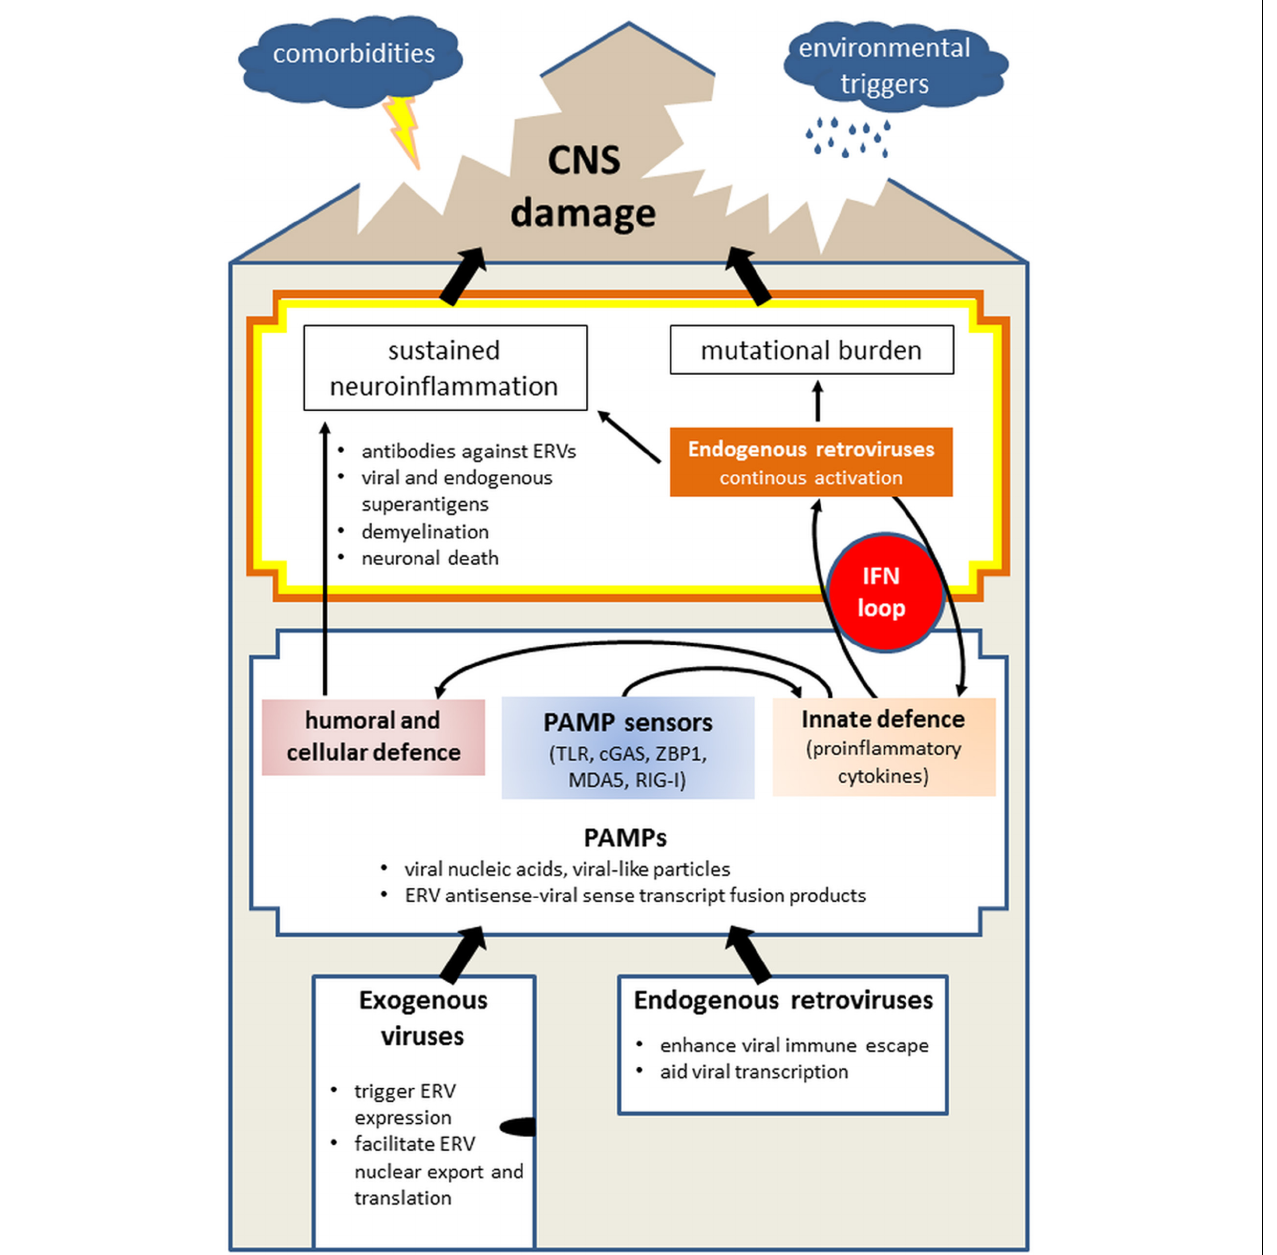
FIGURE 2 | Model of the role of exogenous virus and endogenous retrovirus (ERV) in initiating neuropathologies, illustrating the entry of viruses into the body (“house”) and the presence of ERVs, the physiological immune response on the first level and continuous imbalance on the second, thus leading to damage of the CNS (“roof”). Infections with exogenous viruses often activate the transcription of endogenous retroviruses which are already present in the mammalian genome. This results from disruption of the host-control over ERVs, bordering between own and foreign. Separately and together, activated exogenous viruses and ERVs produce PAMPs, such as viral nucleic acids, viral-like particles, fused transcripts between exogenous virus, and ERV, which are sensed by PAMP sensors (TLR, cGAS, ZBP-1, MDA5, and RIG-I). Collectively, PAMP activation alarms the immune system by initiating innate immune response involving mainly IFN signaling which will trigger the adaptive (humoral and cellular) immunity. Viral infections are generally limited in time as they are combated by the immune system. However, the activation of ERVs and neurotrophic viruses which remain silent yet present within the body, can lead to sustained neuroinflammation via antibodies against ERVs, superantigen formation, demyelination, and neuronal death. In parallel, IFN-mediated innate immune response can further activate ERVs which contain IFN response elements (such as HERV-K), thereby creating an IFN loop. Next to the danger of chronic neuroinflammation, this additionally carries mutational burden for the host, collectively leading to the CNS damage. The probability and scope of the CNS damage is further determined by facilitating factors, including comorbidities and environmental triggers as well as age. Abbreviations: cGAS, cyclic GMP-AMP synthase; CNS, central nervous system; ERV, endogenous retrovirus; IFN, interferon; MDA5, melanoma differentiated associated gene 5; PAMP, pathogen-associated molecular pattern; RIG-I, retinoic acid inducible gene I; TLR, toll-like receptor; ZBP-1, Z-DNA binding protein 1.